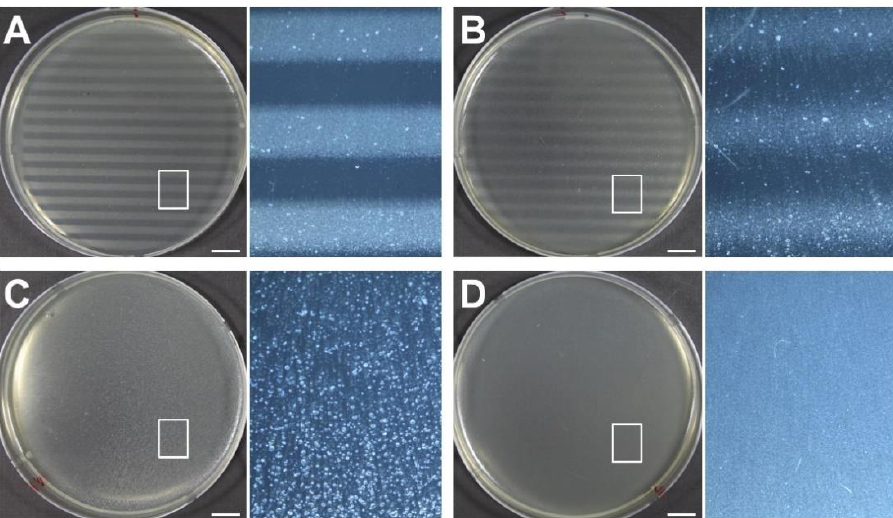
Figure 7. Biological responses of bacterial cells to proton minibeams at the various phantom depths, such as ( A ) surface, ( B ) 2 cm, and ( C ) mid-SOBP, and their comparison with ( D ) non-irradiated control cells. The doses delivered to the peaks and valleys were estimated to be 72 CGE and 2.5 CGE at surface, 72.3 CGE and 5.4 CGE at 2 cm depth, and 48.5 CGE and 47.8 CGE at mid-SOBP, respectively. Each panel at the right side shows magnification of the boxed area in the adjacent panel. Scale bars indicate 1 cm.